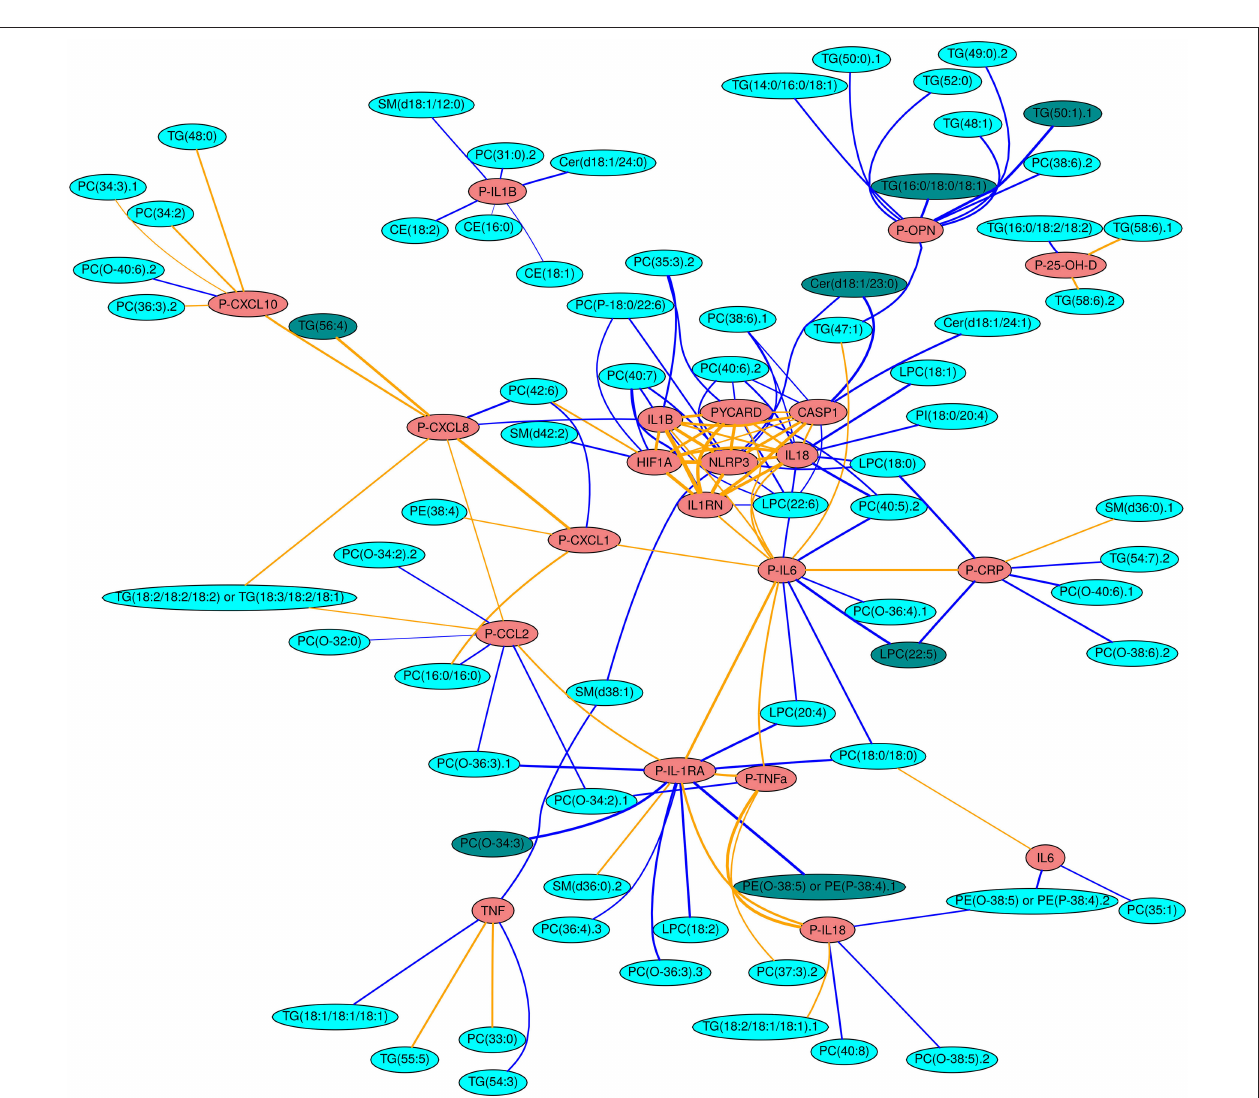
FIGURE 2 | Network projection of all non-spurious (NRR < 0.1) correlations between immune mediators and lipids. Red nodes indicate gene expression data or plasma protein data (P-) of immune mediators and cyan nodes indicate circulating lipids. The darker shade of cyan indicates the lipids with the strongest ( ≥ 0.5), correlations across all patients (see Methods). Blue lines denote negative correlations, whilst orange lines denote positive correlations. The thickness of the lines is scaled to the magnitude of the correlation.